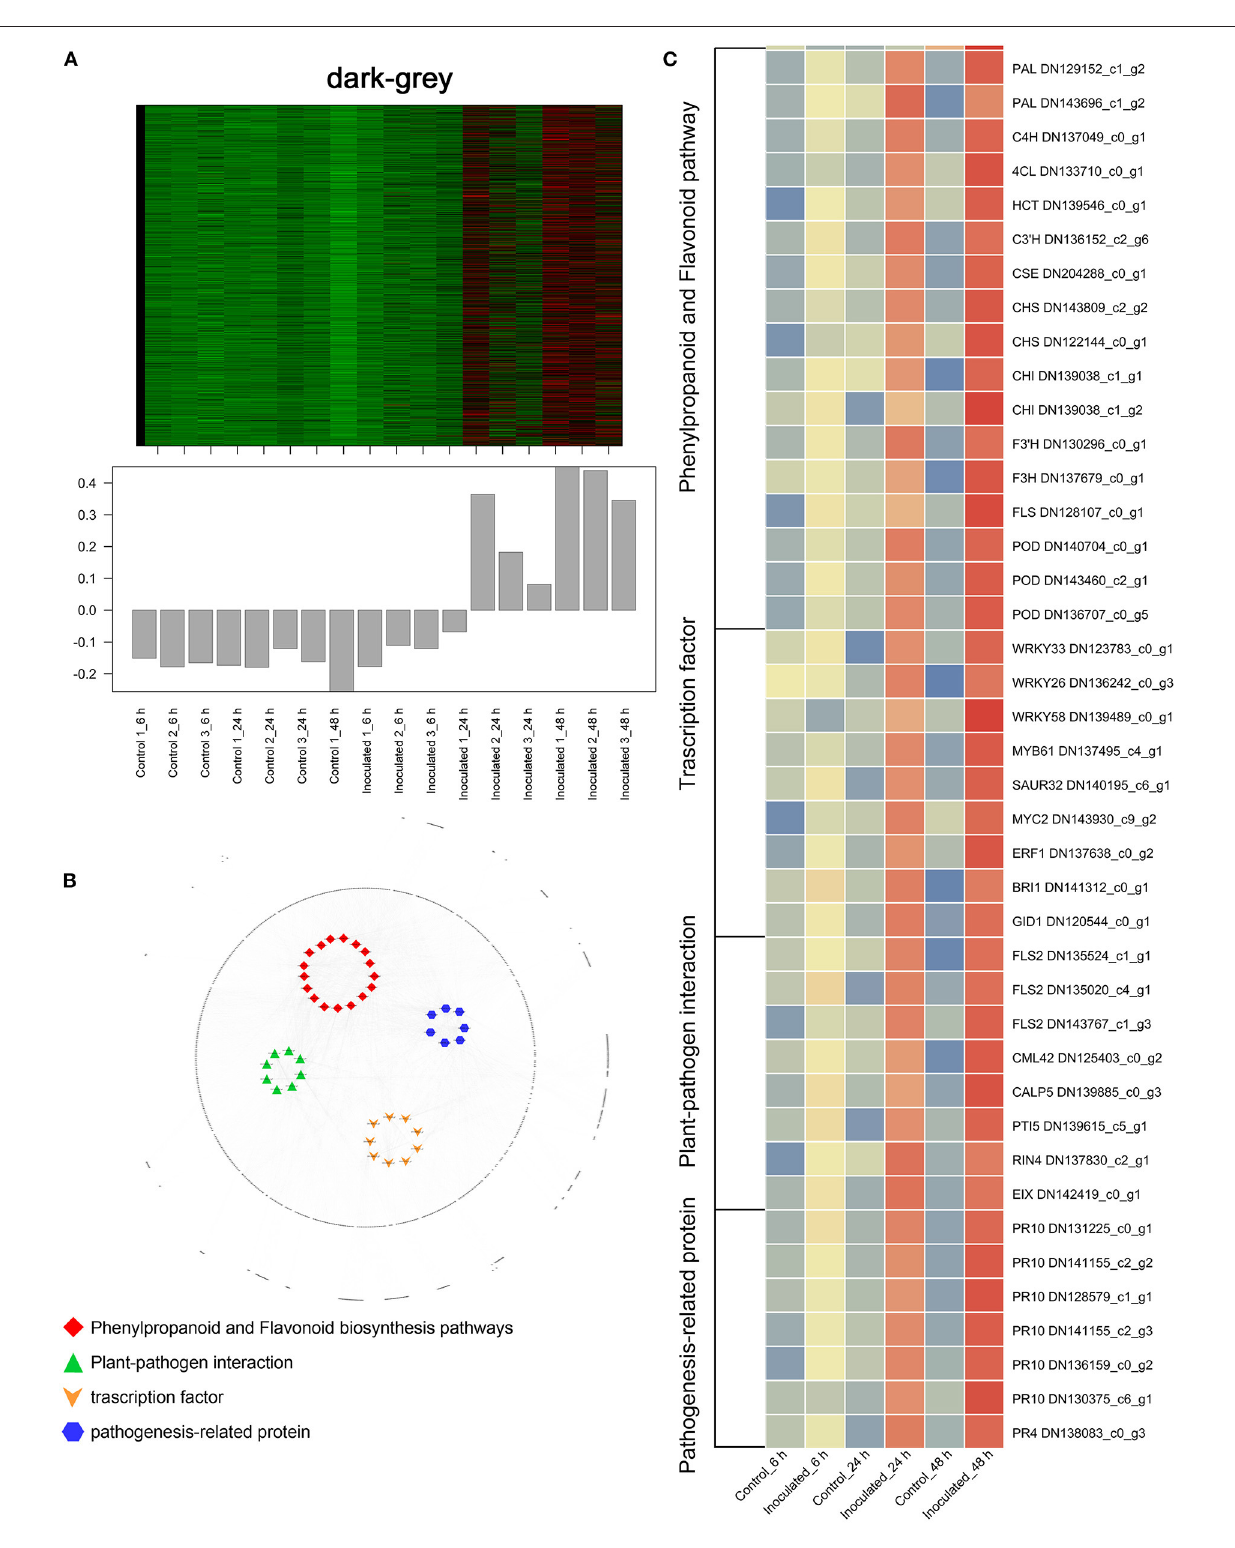
Frontiers in Plant Science |